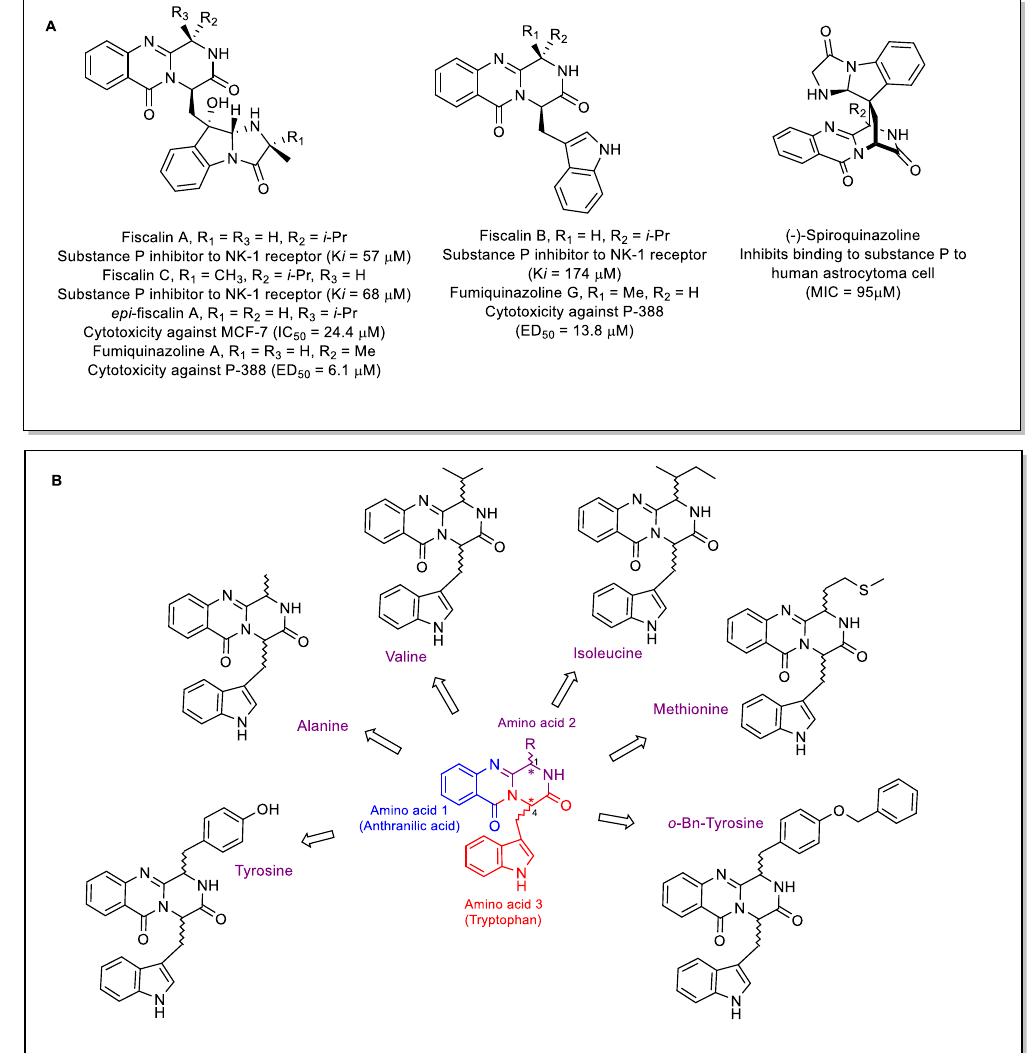
Figure 1. ( A ) Structure of natural quinazolinone-containing piperazine linked to an indole moiety such as substance P receptor antagonists and antitumor agents. ( B ) Proposed conformation constraint peptidomimetics synthetic quinazolinone alkaloids with different substituents at